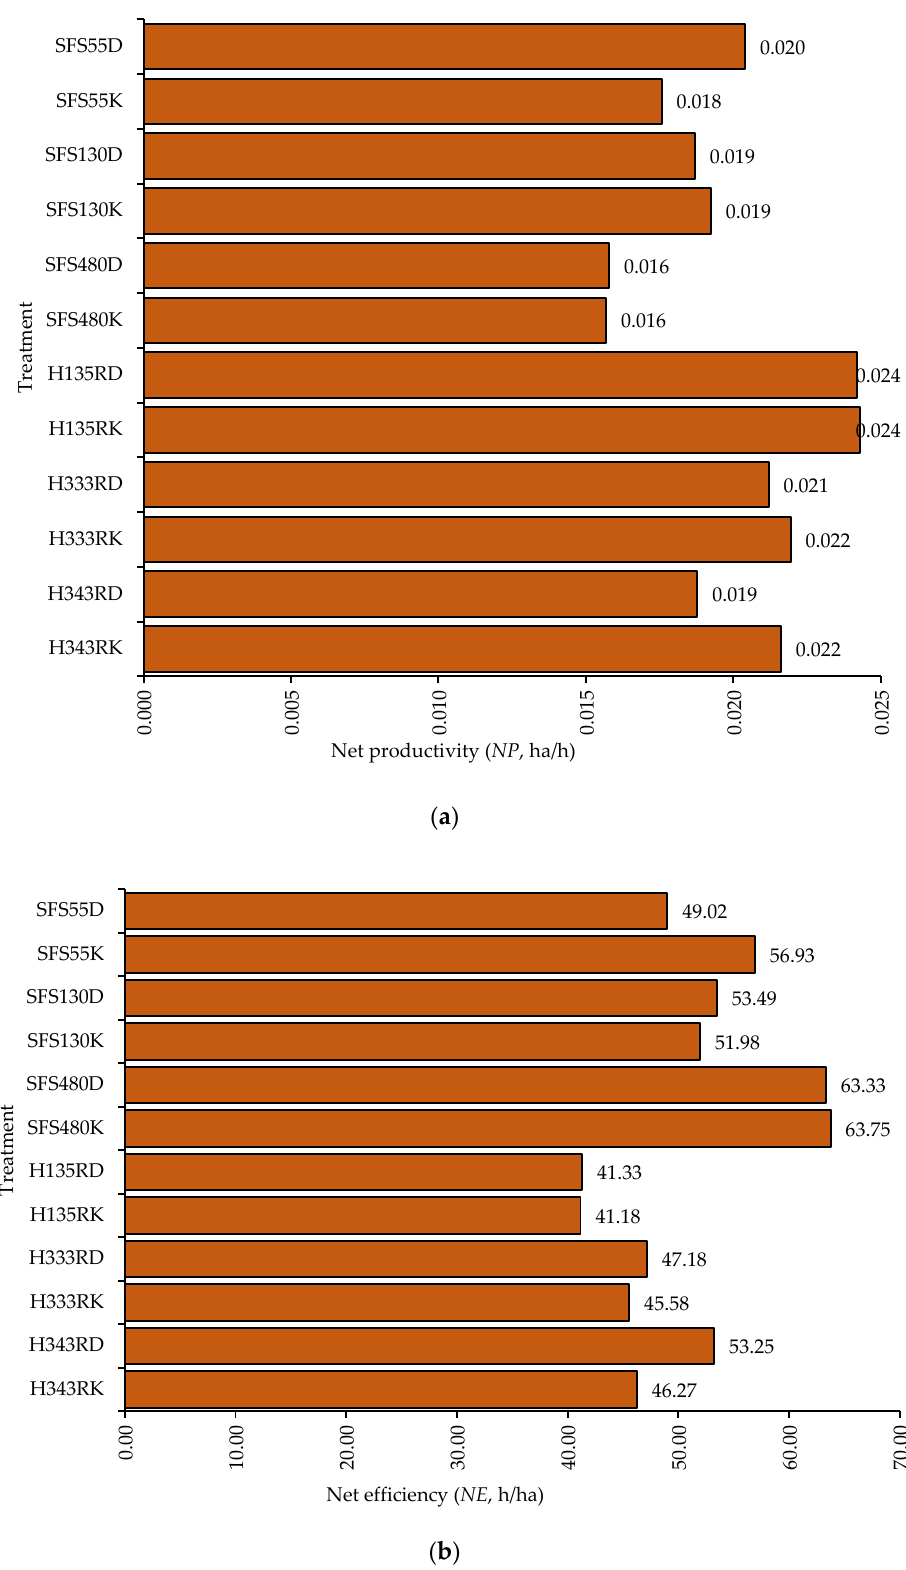
Figure 2. Breakdown of the treatment-level estimates on the net productivity ( NP , ha/h) ( a ) and net efficiency ( NE , h/ha) ( b ).